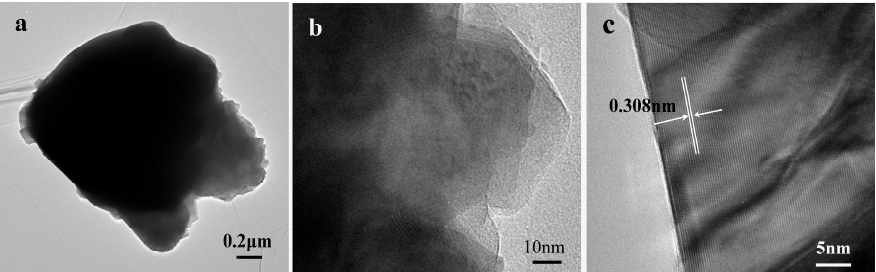
Figure 4. ( a , b ) TEM images and ( c ) HRTEM image of sample H700.